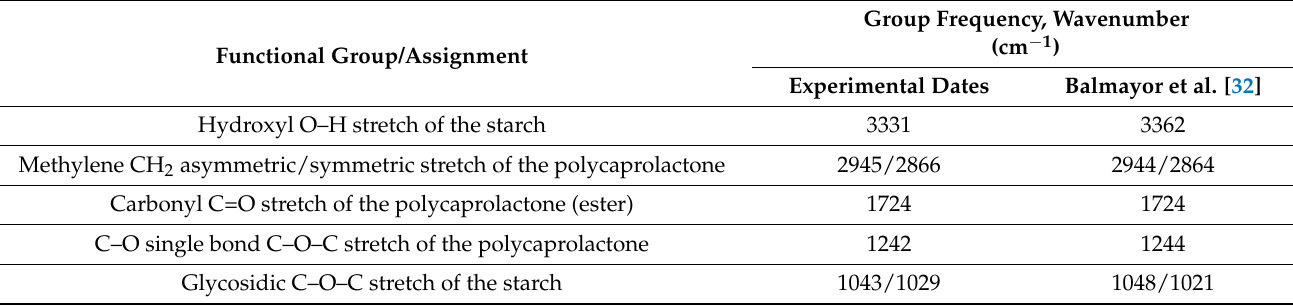
Table 1. Characteristic bands and type of bond for the TPS/PCL binary blend (50/50).